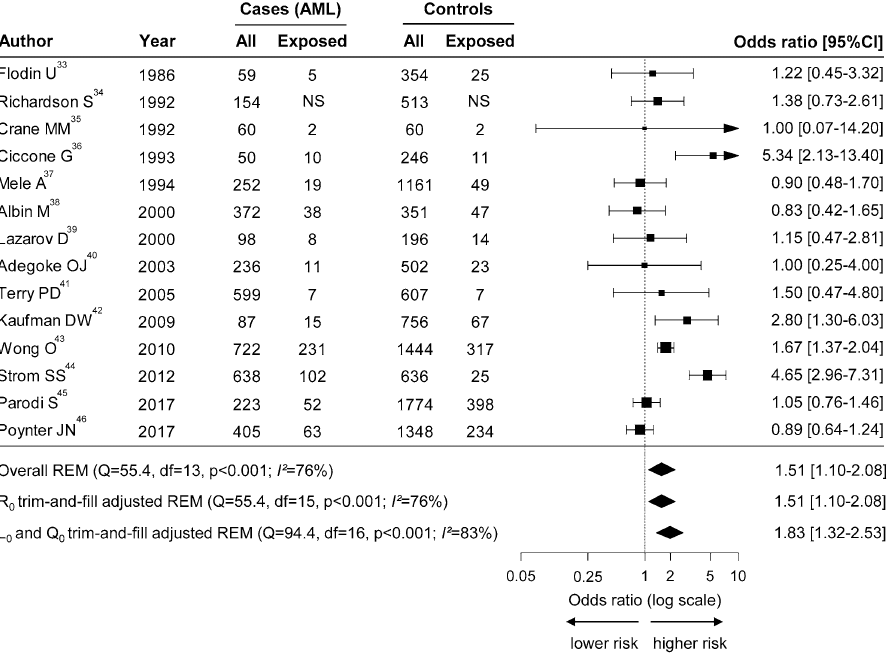
Figure 3. Forest plot illustrating the overall significant increase of acute myeloid leukemia (AML) risk in populations exposed to occupational pesticides. The overall cumulative analysis was calculated with adjusted odds ratio (OR) whenever available, using the random effect model (REM). Pesticide exposure had to be clearly stated in each study, its definition being reported in Table S2. Matching and adjustments strategies are reported in Table 1 and Table S6. Squares indicate the OR for each study, solid diamonds show the pooled meta-analysis estimates and error bars are defined as the 95% confidence interval (95%CI). The size of squares correlates to the weight of each study in the meta-analysis. Publication bias adjustments using trim-and-fill methodology are reported below the overall REM. Imputed analyses are shown in Fig. 5. Q: Cochrane Q-test, df: degree